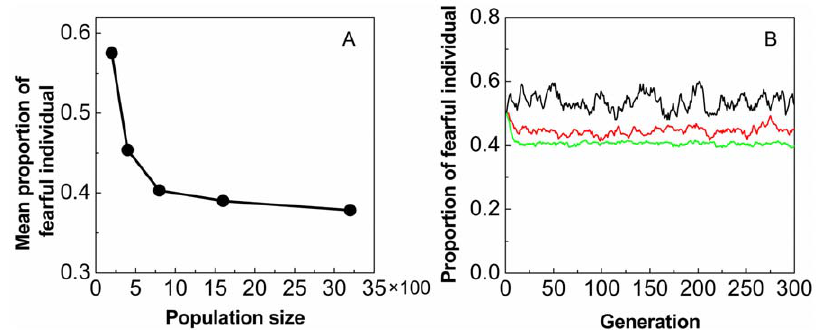
Figure 4. The effect of interactions between individuals on the co-existence of fearfulness and boldness, where the parameters in , N ( t ) ) and W b ( N ( t ) , N ( t ) ) are taken as: d f ~ d b ~ 1 : 0 , h ff ~ 1 : 2 , h fb ~ 0 : 6 , h bb ~ 1 : 4 , and h bf ~ 0 : 4 . (A) The mean background fitnesses W f ( N ( t ) f b f b proportions of fearful individuals (for the last 100 generations) decreases with the increase of the total population size. (B) The strength of random fluctuation in the frequency of fearfulness decreases with the increase of the total population size, where black line: N total ~ 200 ; red line: N total ~ 400 ; and green line: N total ~ 800 .